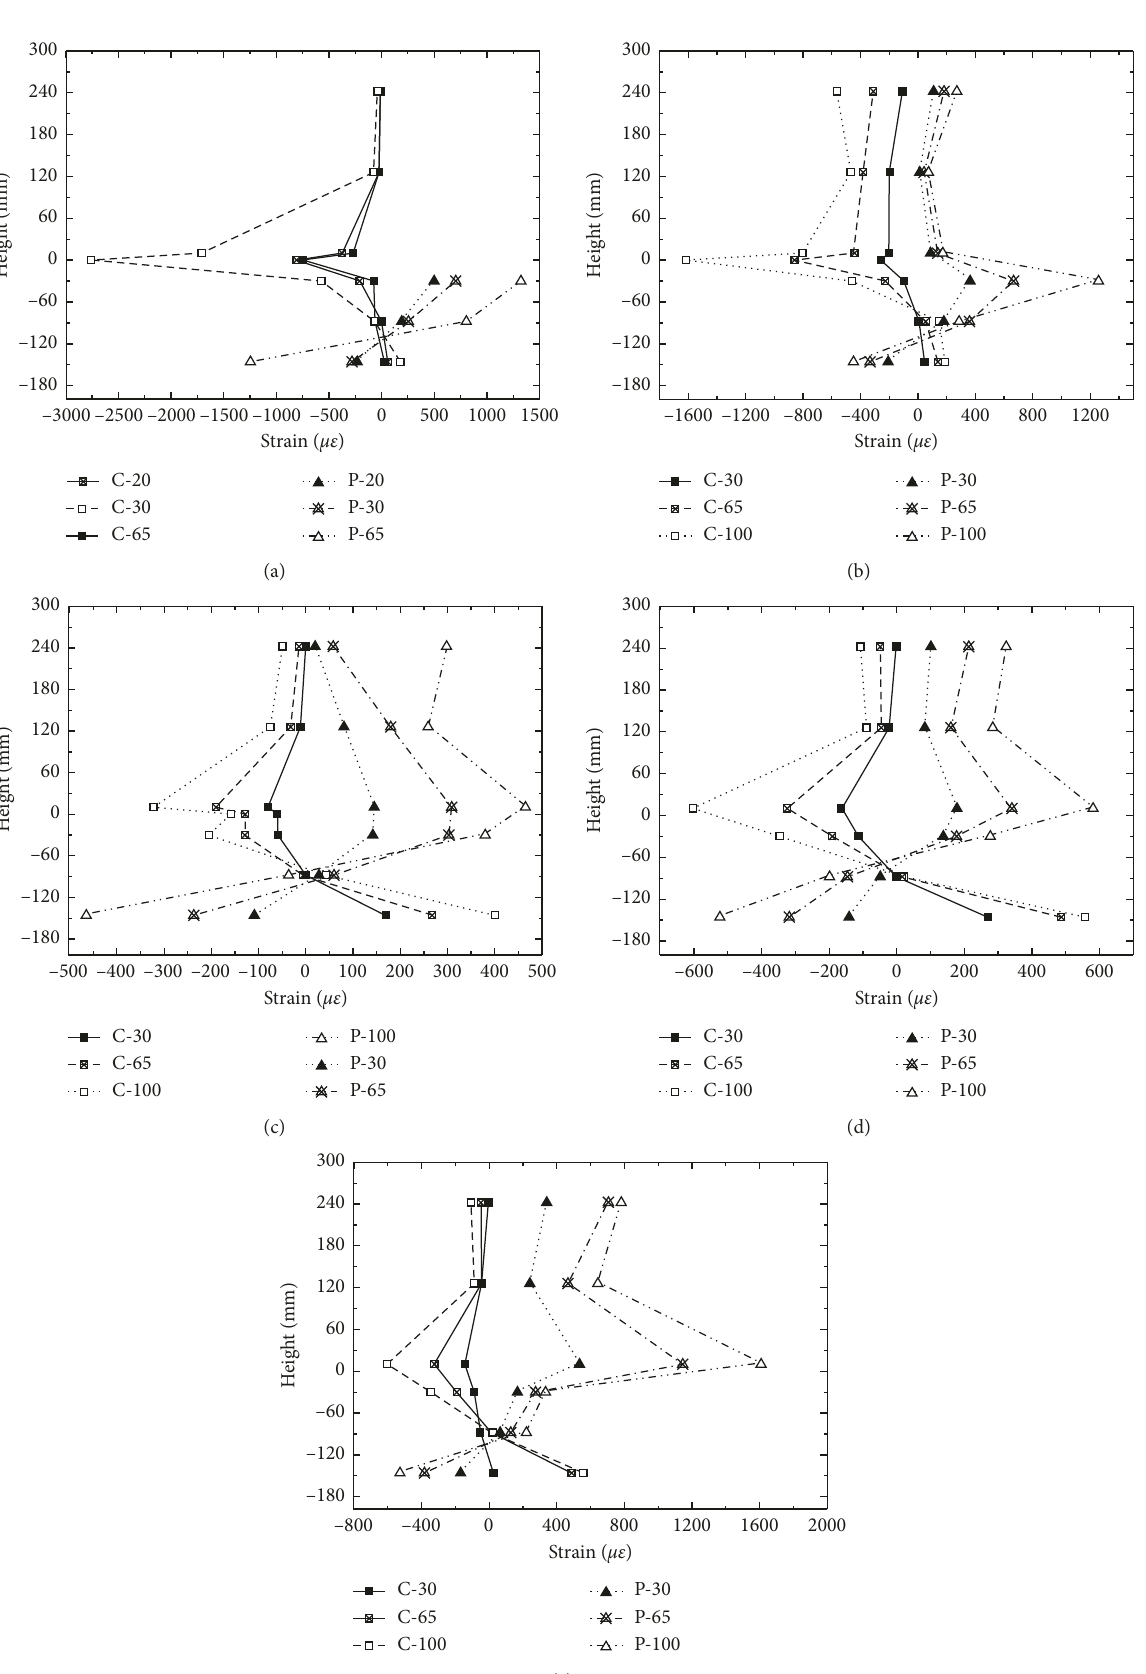
Figure 8: Key parameters in the moment-rotation relationship of specimens. (a) SJ-1. (b) SJ-2. (c) SJ-3. (d) SJ-4. (e)